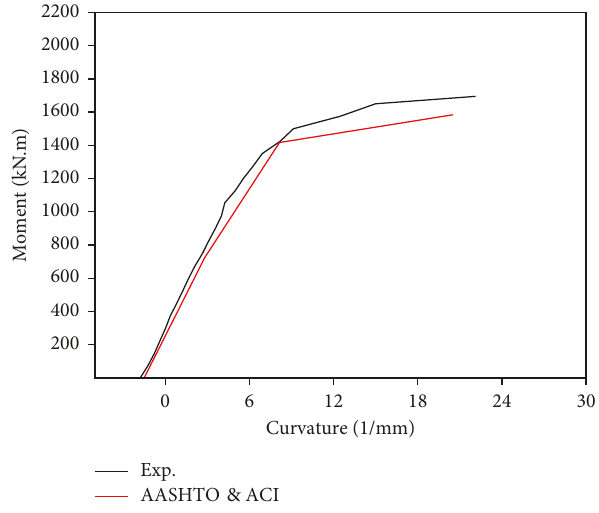
Figure 12: Moment–curvature for control girder G1.